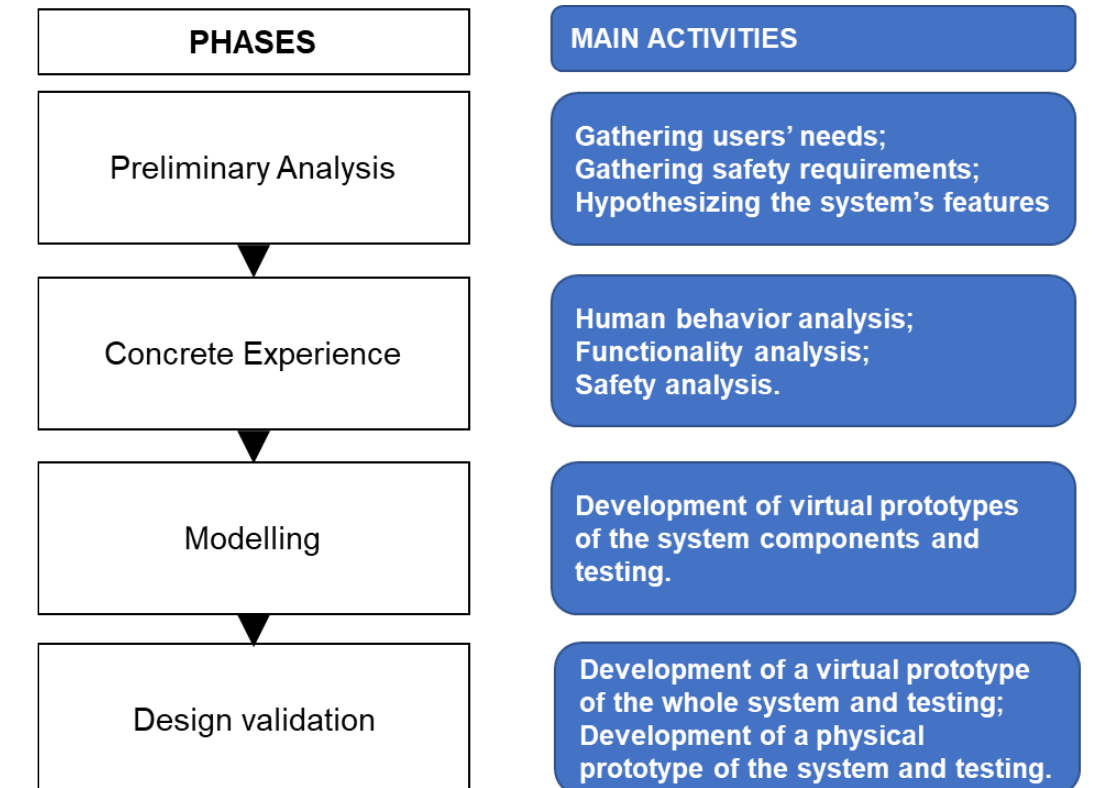
Figure 2. Scheme of the proposed research approach.